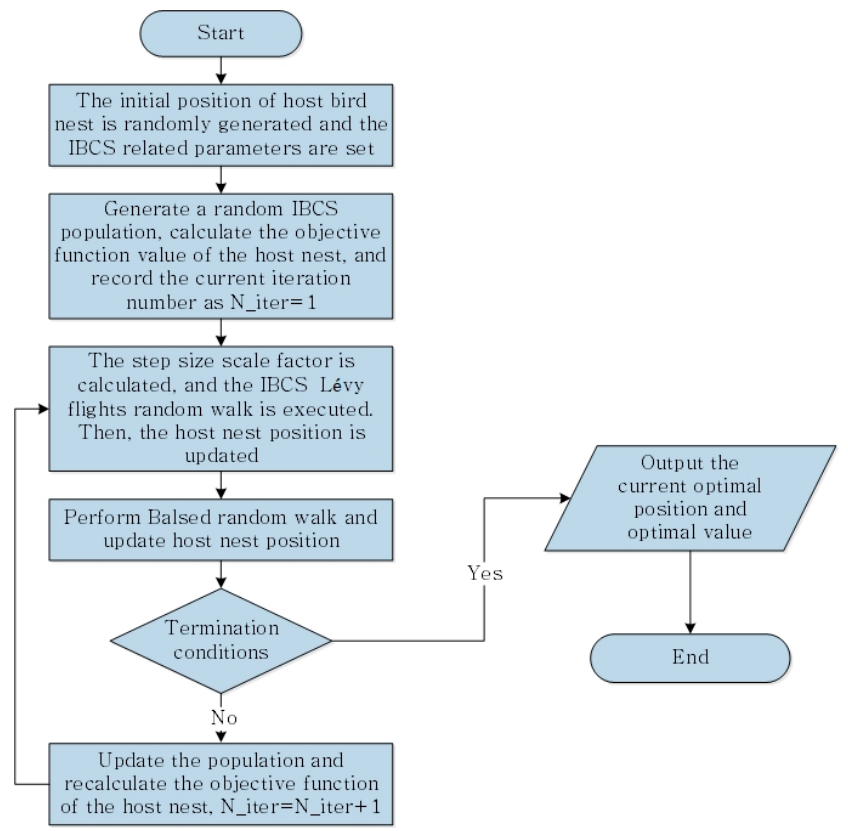
Figure 1. Flow chart of IBCS algorithm.